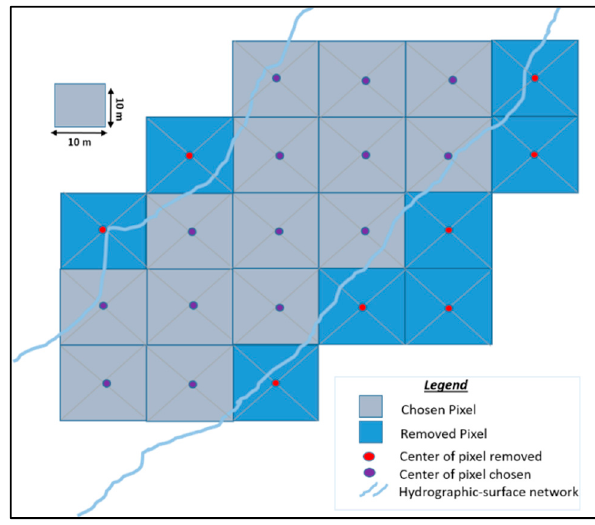
Figure 2. Selection of Sentinel-2 pixels in the surface hydrographic network.